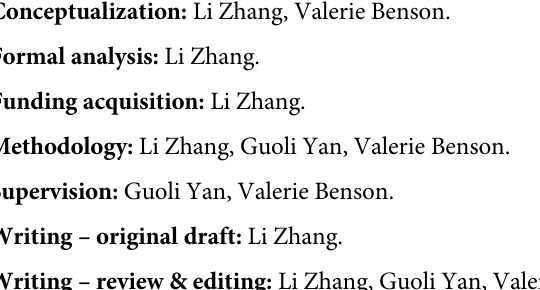
S3 Table. Fixed effect estimates for